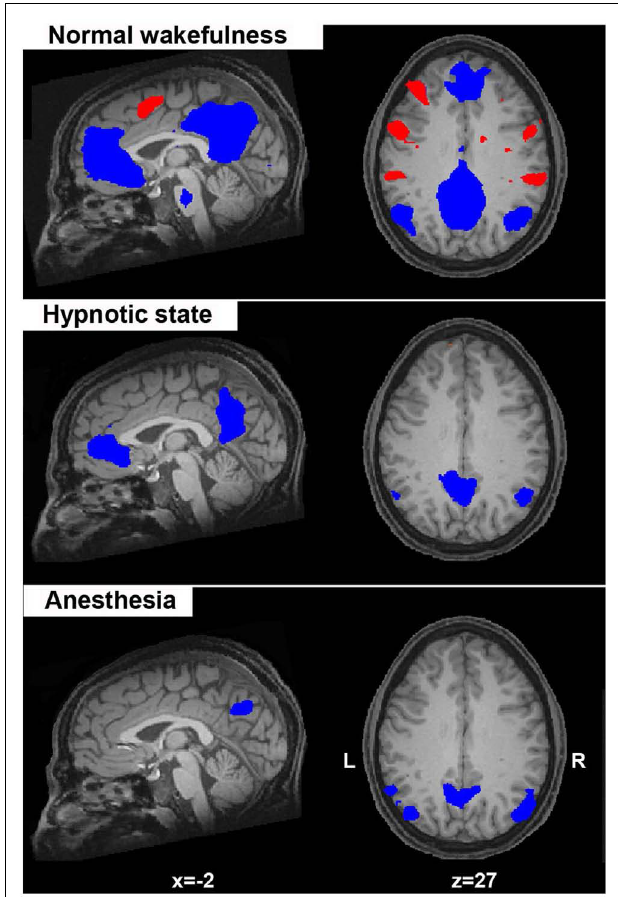
FIGURE 2 | Spontaneous fMRI BOLD activity in the default mode network (in blue; considered to reflect self-related mentation) anticorrelates with the activity of a lateral frontoparietal system (in red; considered to mediate conscious perception of the external world). Here, this anticorrelated activity is shown for normal wakefulness, hypnotic state, and during deep anesthesia. Of note is the absence of the activity in the “extrinsic” frontoparietal system in the two conditions of altered sense of awareness (hypnosis, anesthesia) which is considered as suggestive of a diminished “external” awareness (i.e., the perception of the environment through the senses). Statistical maps are thresholded at a false discovery error rate p < 0.05 and rendered on a structuralT1 magnetic resonance image of a healthy subject ( x and z values indicateTalairach coordinates of the represented